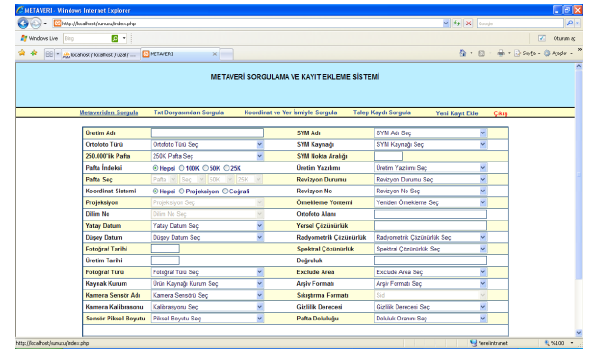
Figure 3. Administrator password login interface